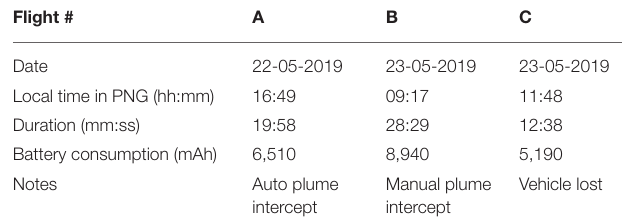
TABLE 2 | Details of the three